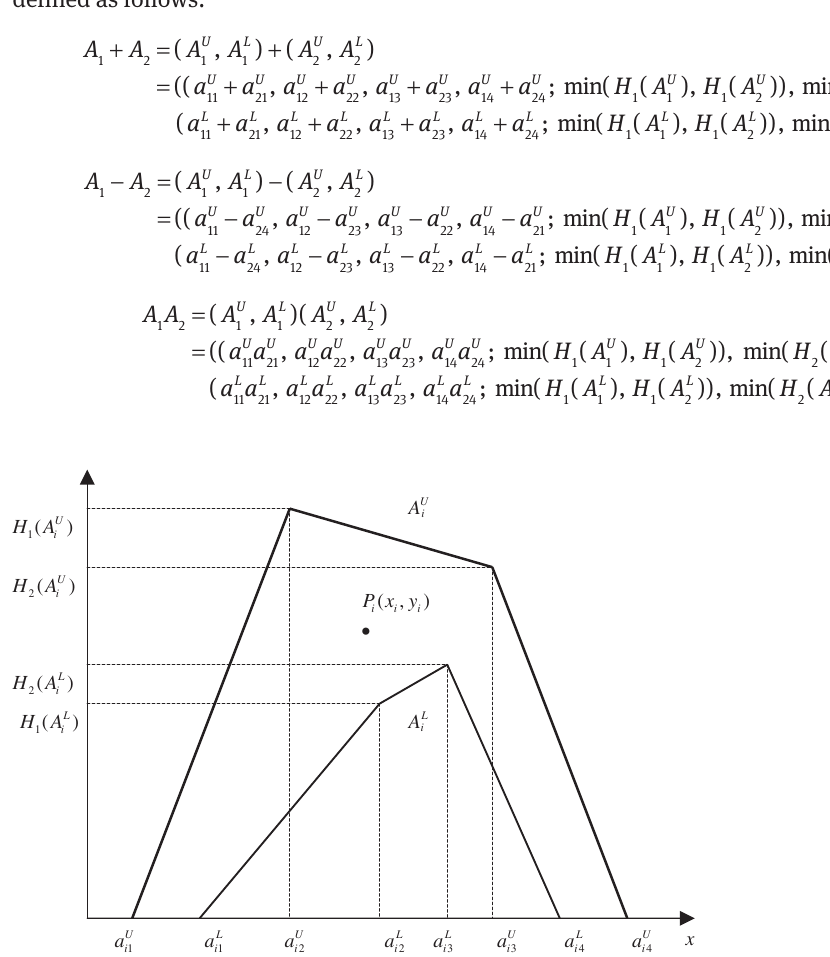
A and the Lower Trapezoidal Membership Function L i